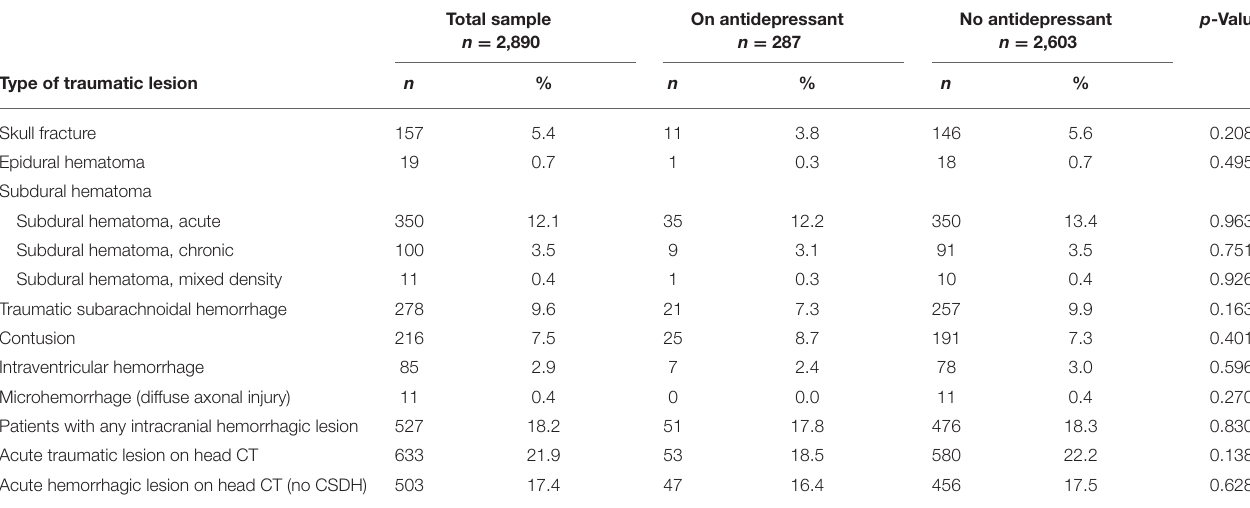
TABLE 2 | Types of traumatic head CT lesions.